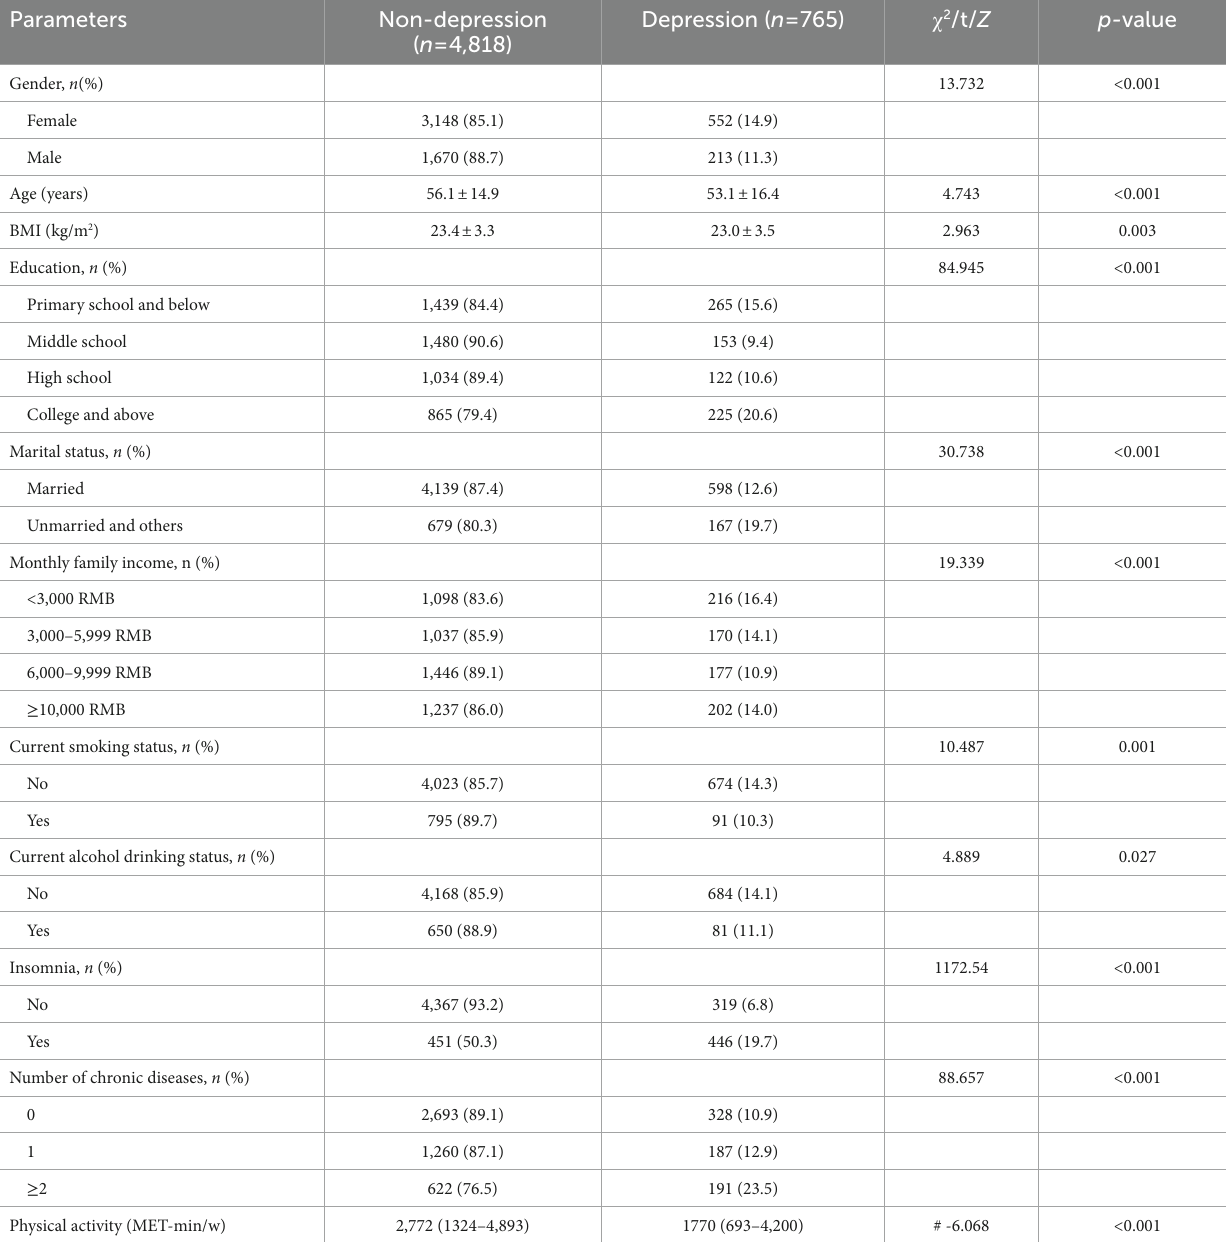
TABLE 1 Demographic characteristics according to depression